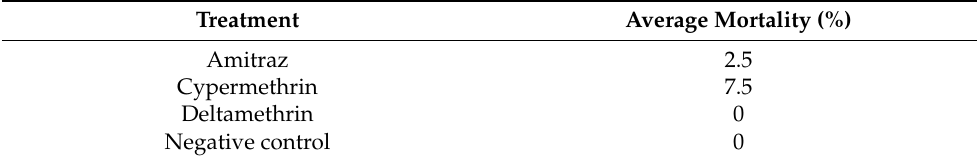
Table 1. Mortality of engorged female R. microplus ticks after immersion in different